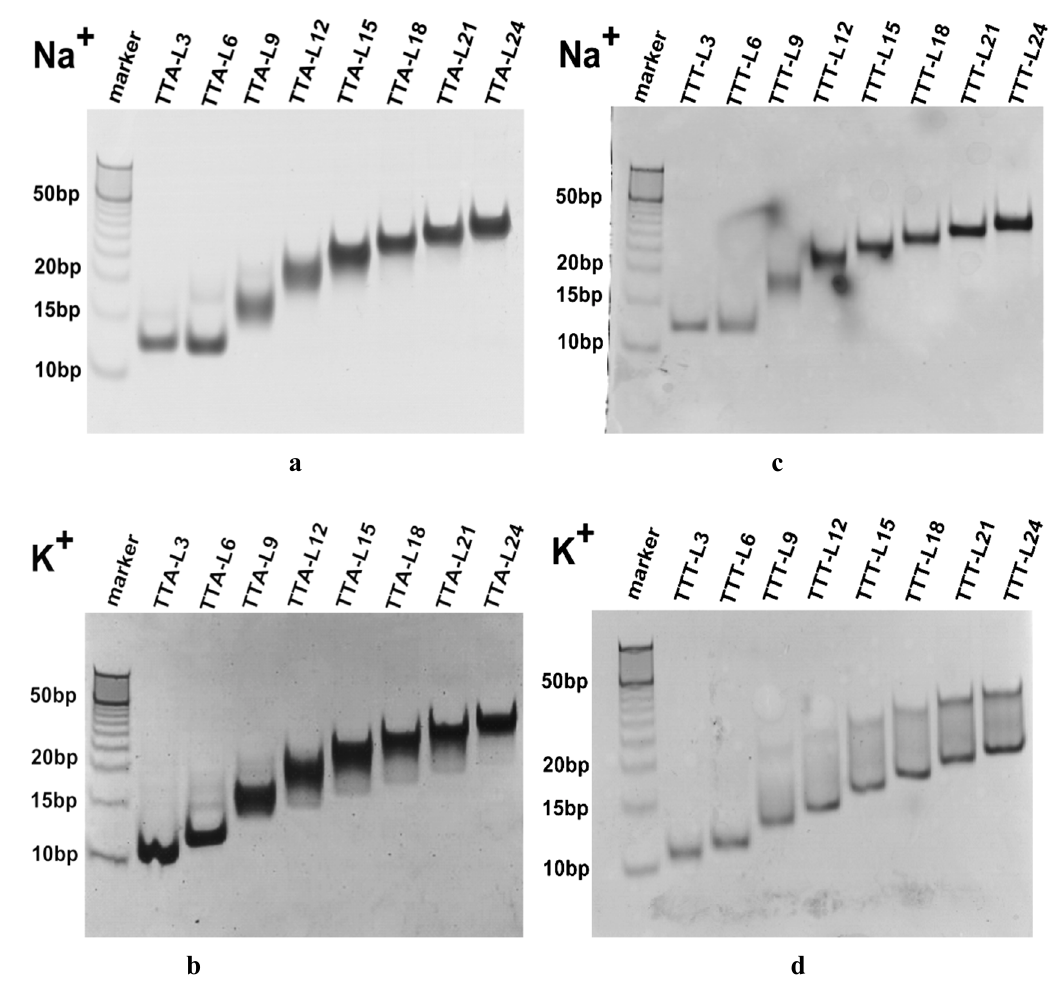
Figure 4. Non-denaturing electrophoresis analysis of TTA series and TTT series. ( a ) TTA series in 100 mM Na + -gel; ( b ) TTA series in 100 mM K + -gel; ( c ) TTT series in 100 mM Na + -gel; ( d ) TTT series in 100 mM K + -gel.